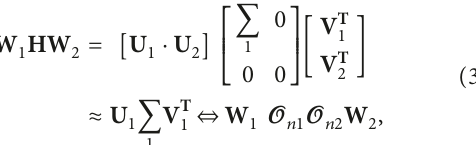
Figure 8: Wave pressure on the caisson foundation at Node 1 under Wave 2. (a) Depth d